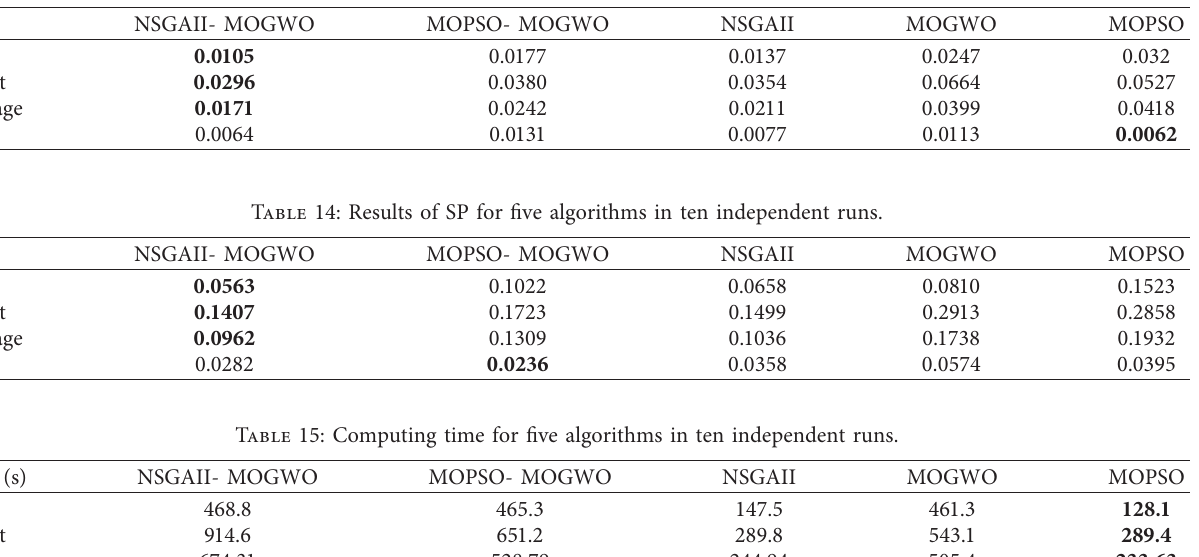
Table 13: Results of GD for five algorithms in ten independent